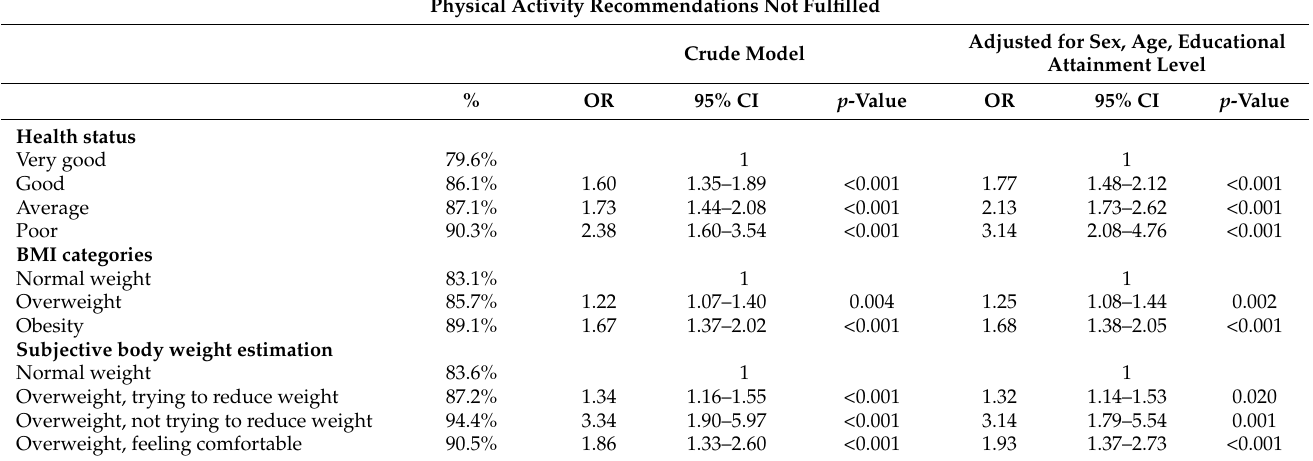
Table 3. Association between not fulfilling the physical activity recommendations and health status, BMI categories, and subjective body weight estimation of farmers.